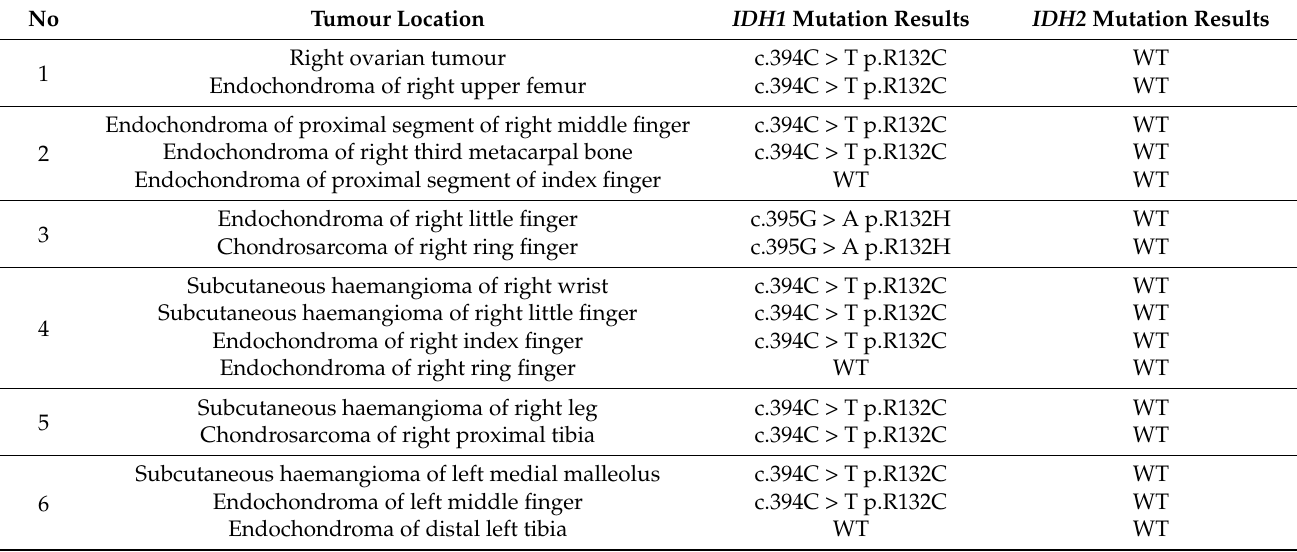
Table 2. Detection of IDH1 mutation in 16